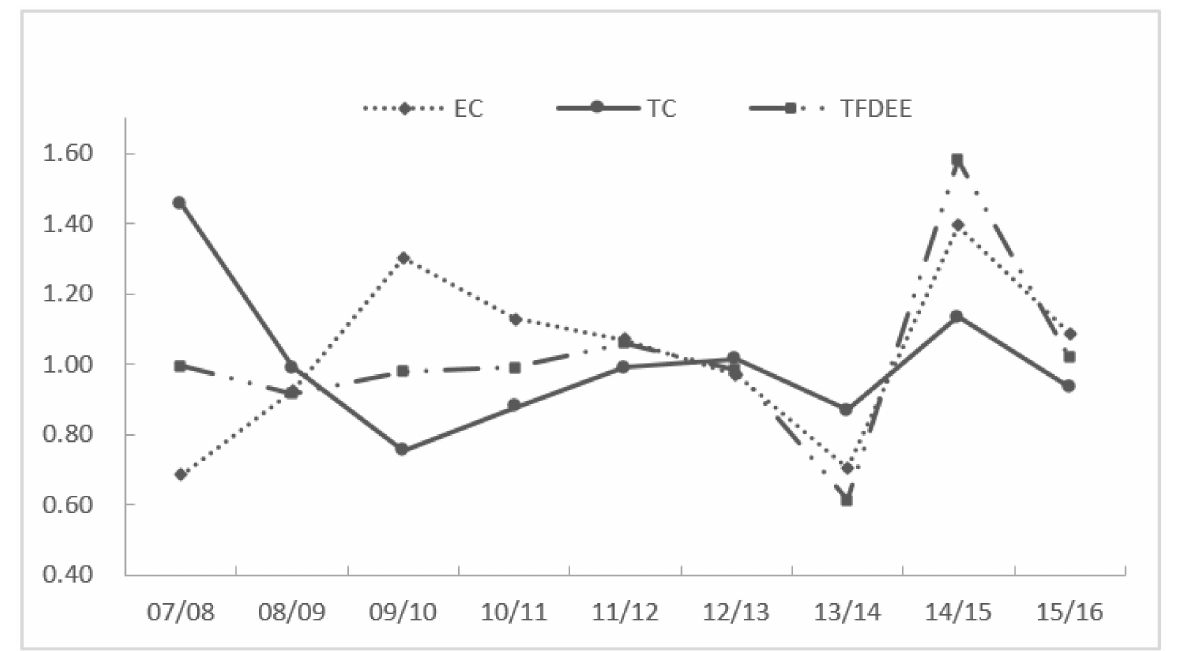
Figure 4. Change trend of TFDEE and its decomposition index in China’s mining industry.